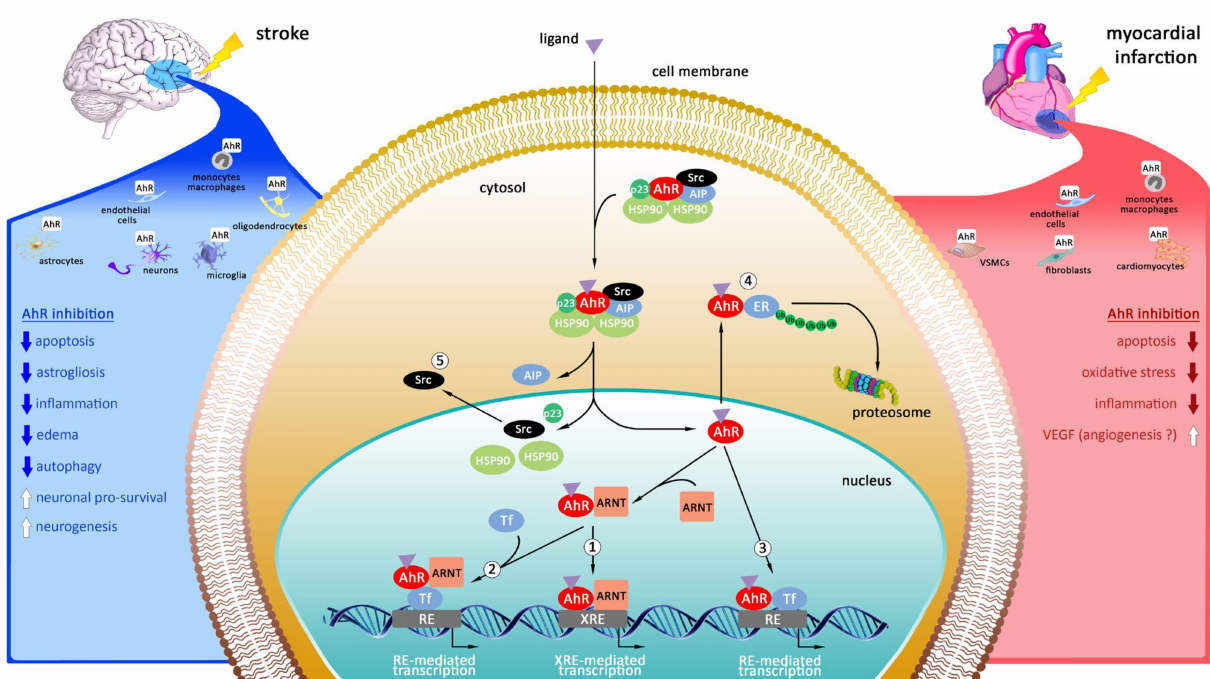
Figure 3. Schematic model representing the cellular localization, the molecular mechanisms and the effects of AhR activation after cerebral and cardiac ischemia. Under unbounded state, AhR is retained in the cytoplasm in an inactive complex. After ligand binding, AIP is released from the complex and the ligand-AhR-HSP90-p23-Scr structure translocates into the nucleus. Inside the nucleus, the ligand-AhR structure is released from the complex and heterodimerizes with the aryl hydrocarbon receptor nuclear translocator (ARNT) and interacts with the xenobiotics response element (XRE) (1), regulating the expression of several phase I and phase II metabolizing enzymes. The ligand-AhR-ARNT (2) and ligand-AhR (3) can interact with other transcription factors (e.g., NF-kB and the estrogen receptor ER), binding to their response elements (RE) and modulating the expression of their target genes. AhR signaling also includes non-genomic pathways: AhR can function as an E3 ubiquitin ligase (4), while the release of the c-Src kinase (5) results in the phosphorylation of multiple